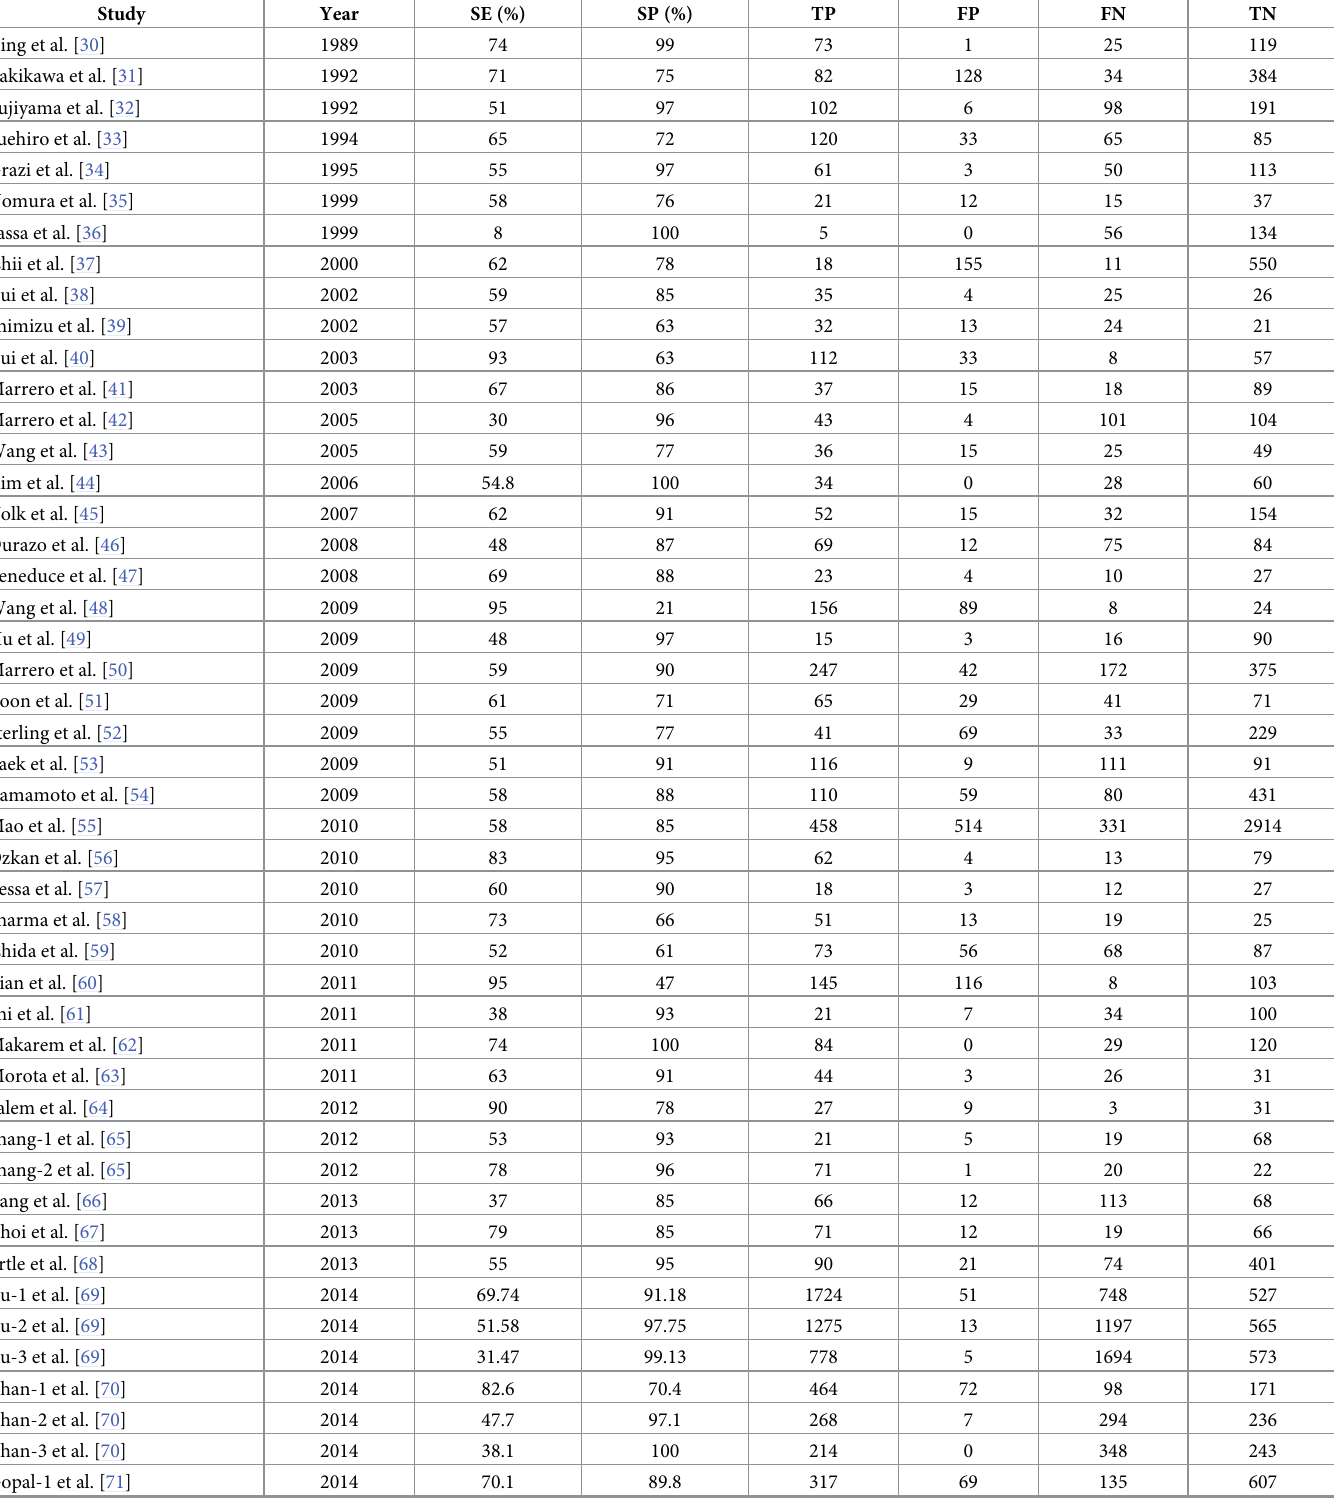
Table 2. The indicators for HCC diagnosis were extracted from the included